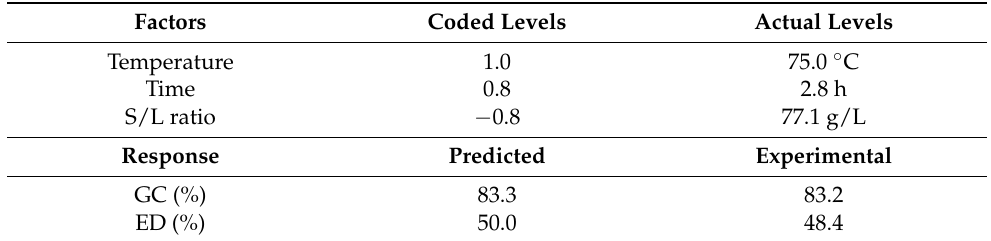
Table 6. Numerical optimization and experimental data for the chestnut shells (CNSs) pretreatment.